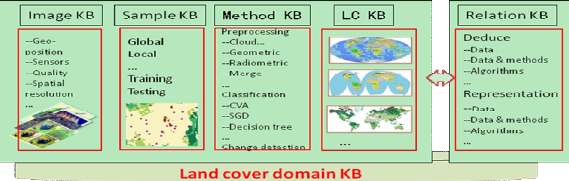
Figure 2. Major components of domain